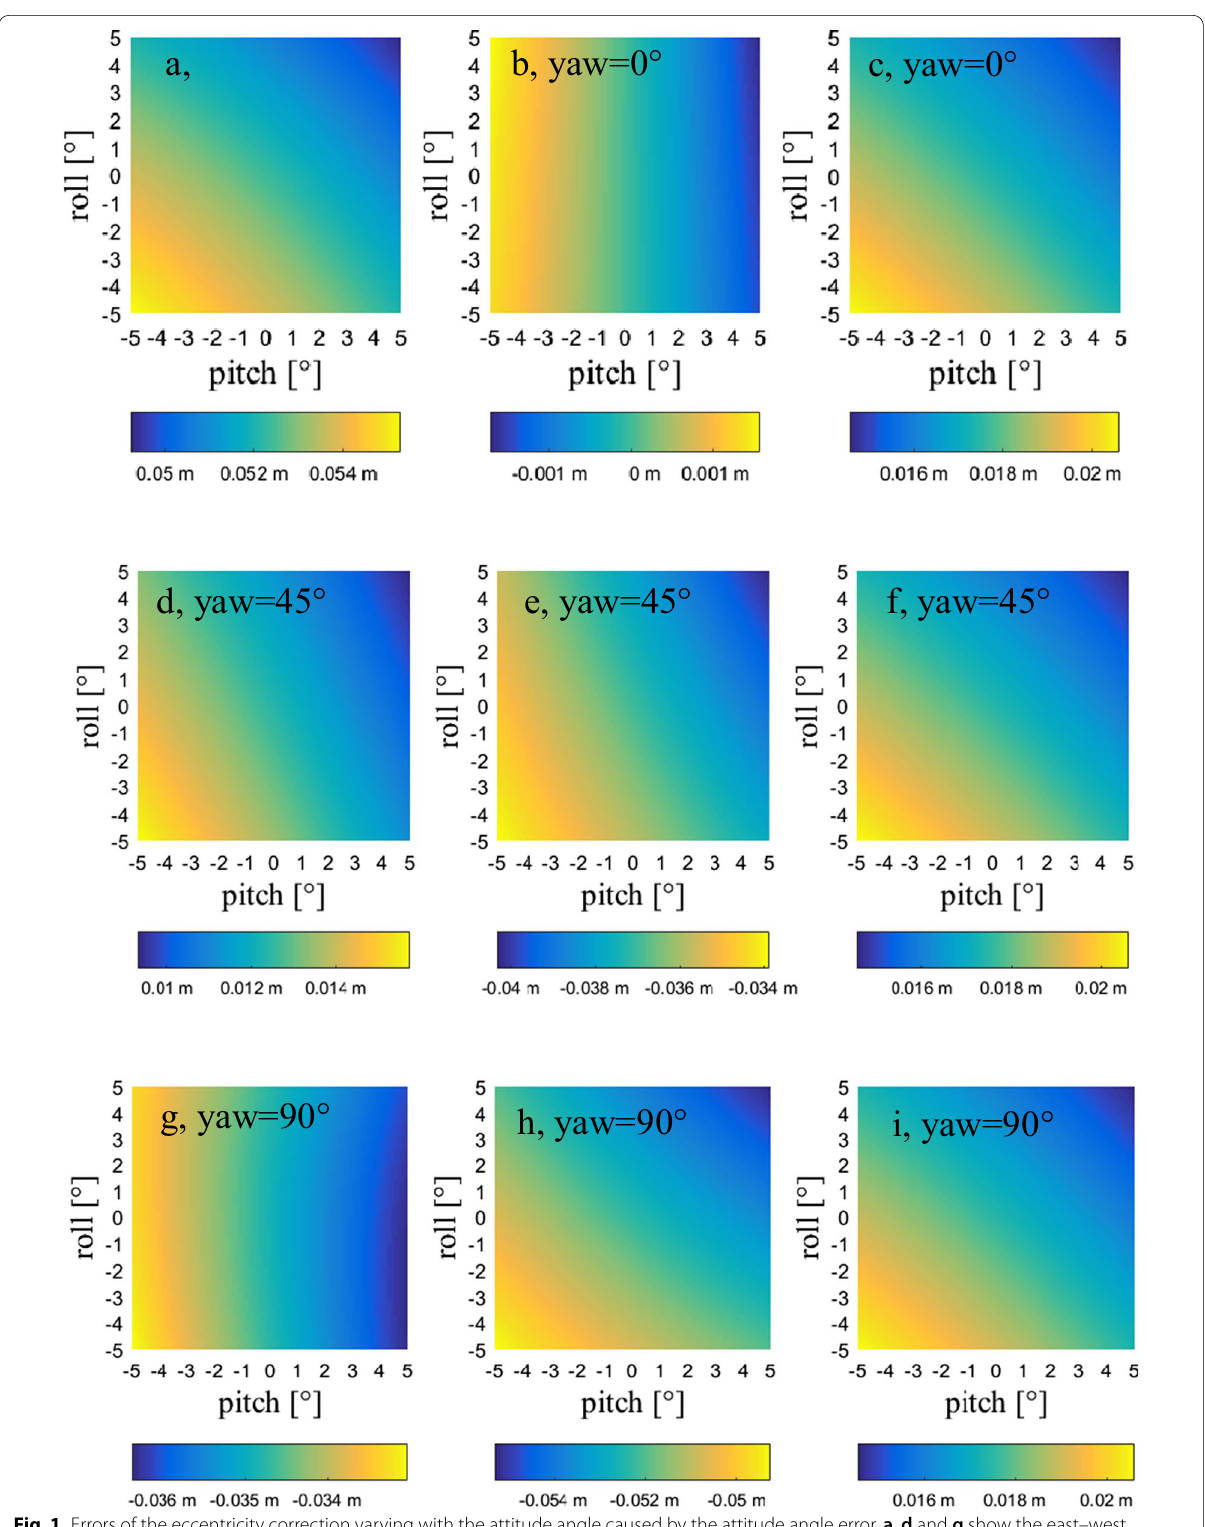
Fig. 1 Errors of the eccentricity correction varying with the attitude angle caused by the attitude angle error. a , d and g show the east–west position errors of the eccentricity correction; b , e , and g show the north–south position errors of the eccentricity correction; and c , f , and i show the elevation position errors of the eccentricity correction. The baseline is taken as (10, 20, 10), and the attitude angle error is set to